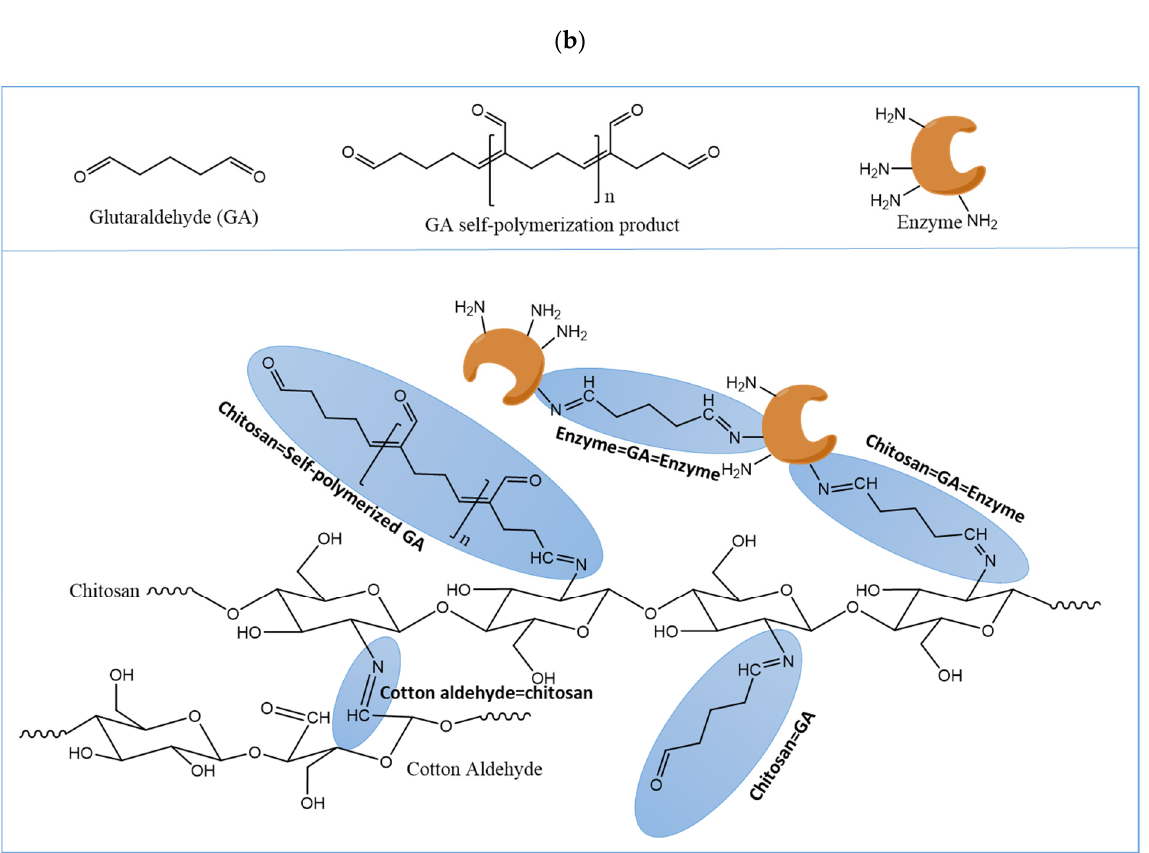
Figure 1. Schematics of enzymes immobilized using different strategies including entrapment, surface only covalent attachment, and hybrid methods ( a ); and, types of chemical linkages that could be present in the sample ( b ).